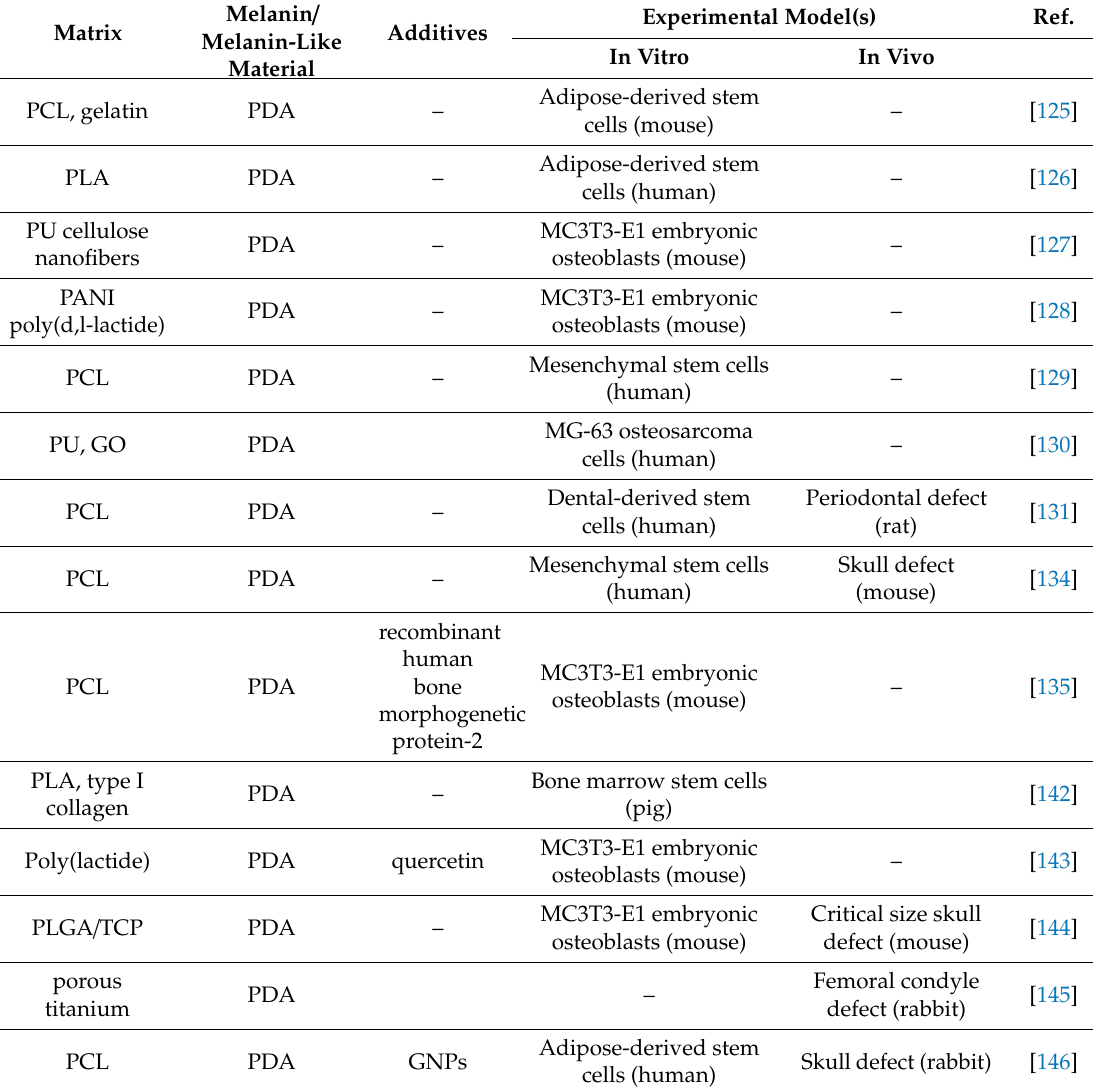
Table 3. Summary of melanin-like materials for bone tissue